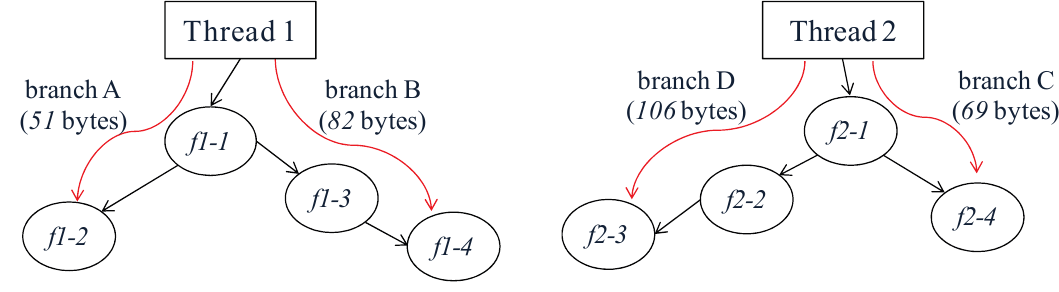
Figure 18. Thread1 has two execution branches: A and B. Stack sizes required by these two branches are 51 bytes and 82 bytes respectively. Thread2 also has two execution branches: C and D, and stack sizes required by these two branches are 69 bytes and 106 bytes,